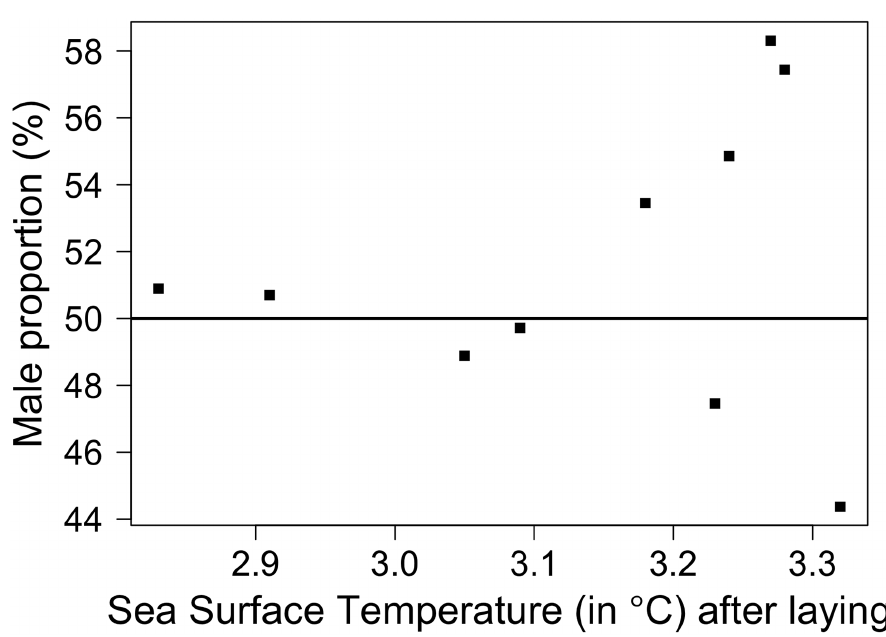
Figure 3. Changes in sex ratio of fledging king penguins according to the Sea Surface Temperature (SST) over a 10-year period. Sex ratio is presented as male proportion (%). SST ( ˚ C) was averaged over the summer season, i.e. the 6-mo period following the onset of reproduction (mean annual laying date of early breeders) (see methods).